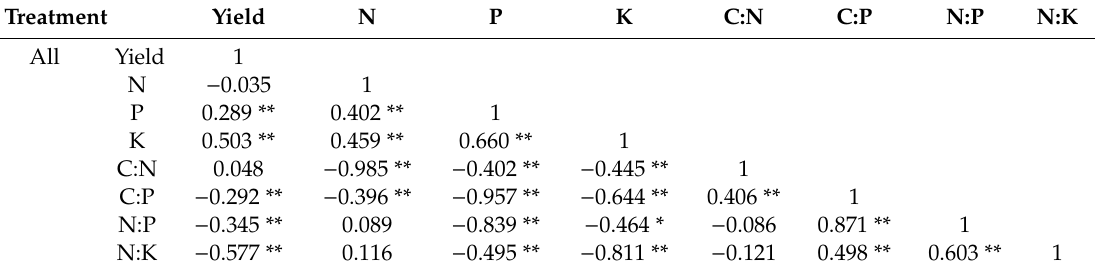
Table 9. Pearson correlation coe ffi cient (r-values) and significance* among plant variables (n all treatments = 108; n = 1,2,3,4